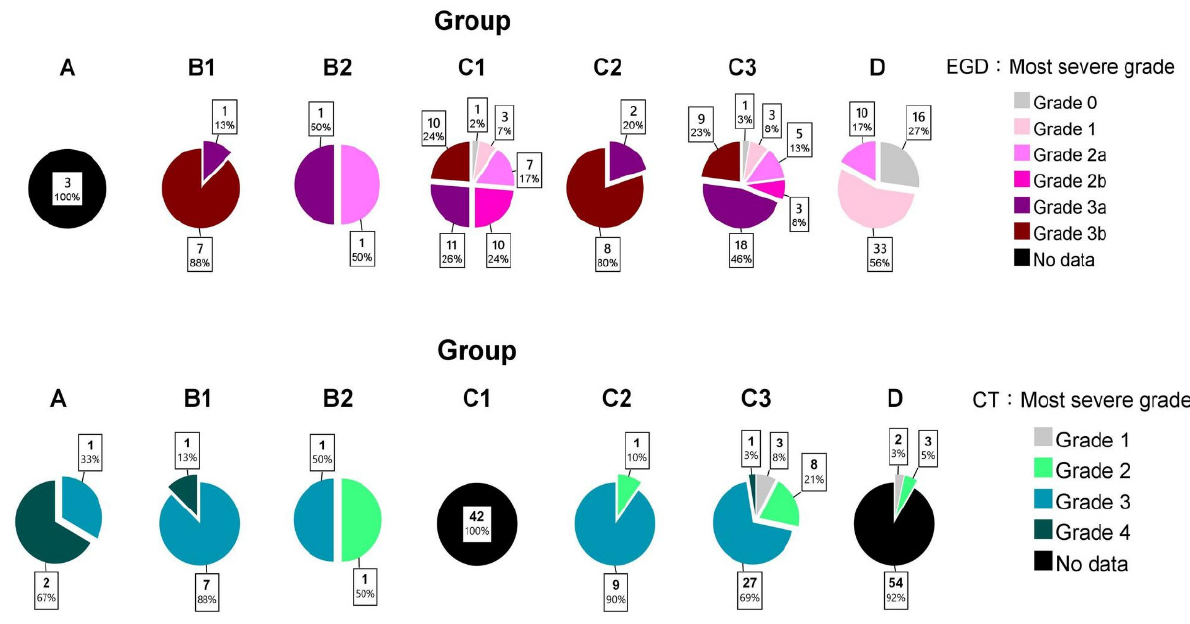
Figure 3. The most severe grade of each patient group estimated using EGD and CT.